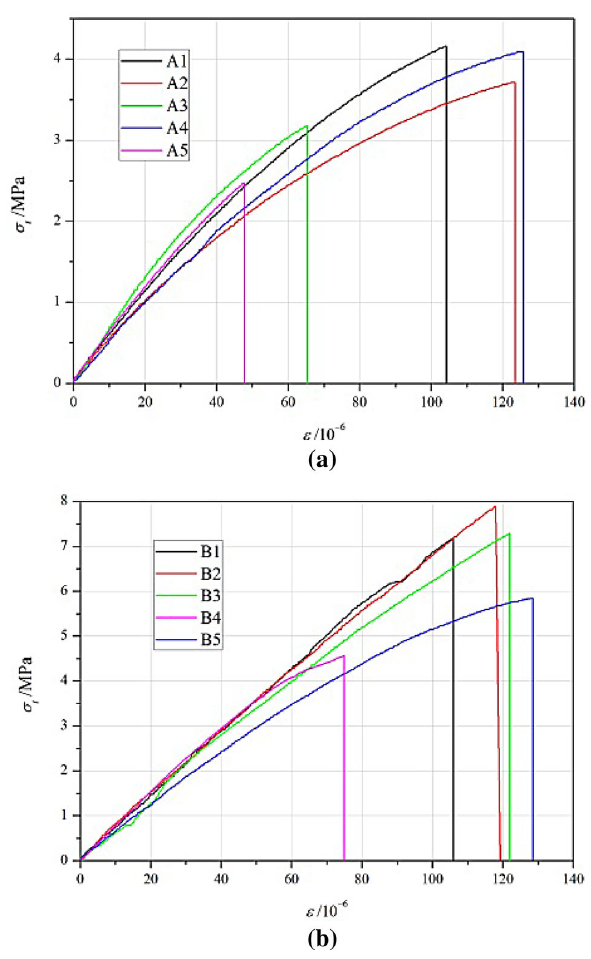
Fig. 2 Tensile stress–strain curves of marble specimens in the two groups. a Group A, b Group B